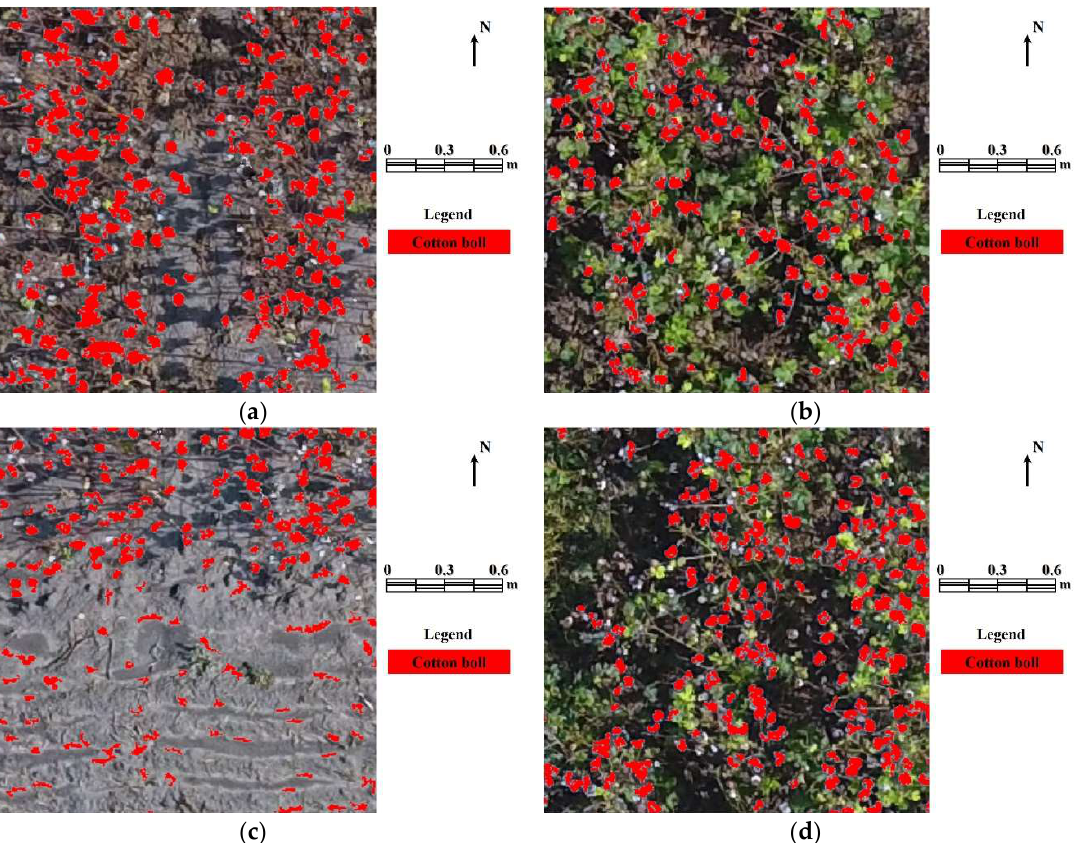
Figure 11. Enlarged cotton boll extraction results. ( a ) N3; ( b ) S3; ( c ) commission errors in N3 caused by bright spots on the ground; ( d ) omission errors in S3 caused by shadowed cotton bolls.